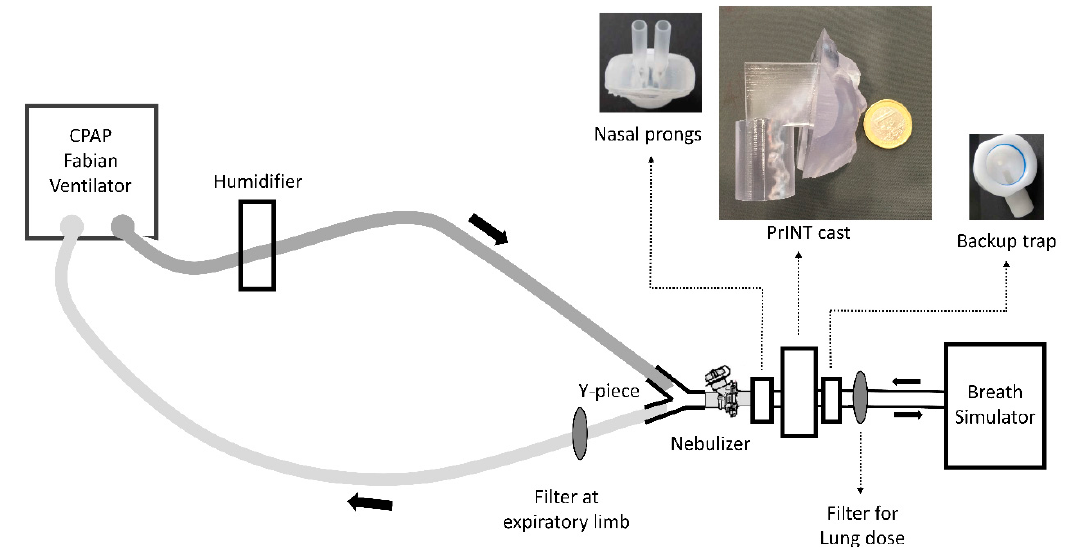
Figure 1. Scheme of the experimental set-up. CPAP, continuous positive airway pressure.